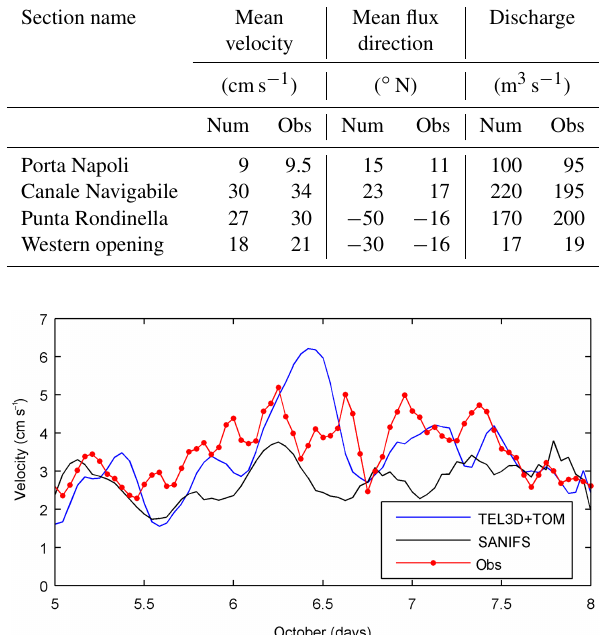
Figure 11. Depth-averaged velocity at the Mar Grande station: numerical results from the coupled TEL3D + TOM run (red line), SANIFS run (black line) and observations (red line and circle mark- ers).